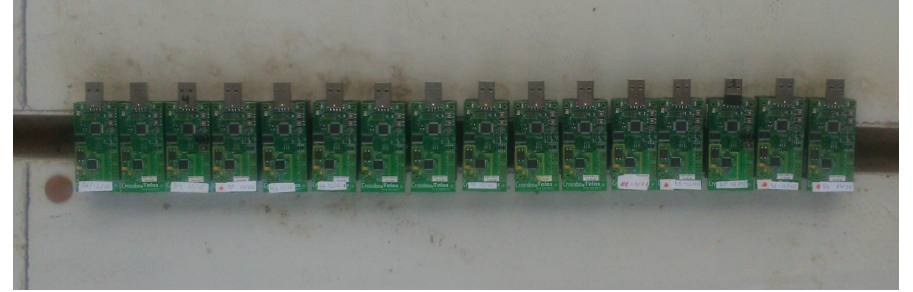
Figure 8. 16 TelosB motes deployed in a straight line to do beamforming in 2.44 GHz with l = λ mote